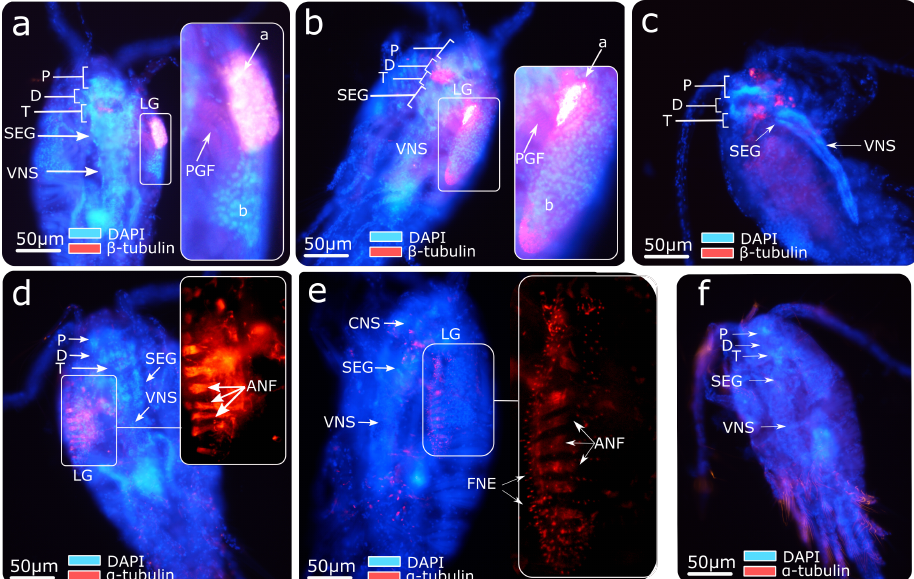
Figure 2. Immunofluorescence of the Oithona nana nervous system. ( a ) Male labeled with β 3-tubulin and DAPI. ( b ) Male labeled with β 3-tubulin and DAPI. ( c ) Female labeled with β 3-tubulin and DAPI. ( d ) Male labeled with α -tubulin and DAPI. ( e ) Male labeled with α -tubulin and DAPI. ( f ) Female labeled with α -tubulin and DAPI. P: protocerebrum. D: deutocerebrum. T: tritocerebrum. SEG: suboesophageal ganglion. VNS: ventral nervous system. LG: lateral ganglion. PGF: post-ganglion fibers. a: β 3-tubulin-rich area. b: nuclei-rich area. ANF: afferent nerve fibers. FNE: free nerve